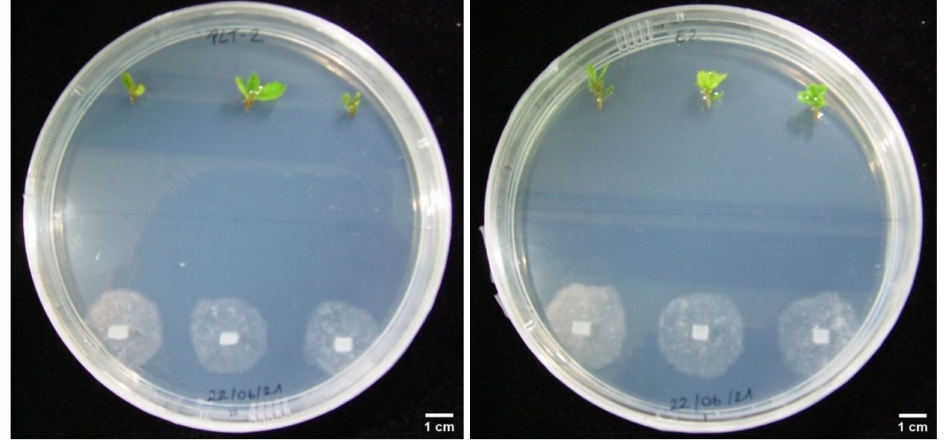
Figure 3. Growth of P. cinnamomi mycelia after 3 days of dual culture, when confronted with shoots of a Q. ilex tolerant (PL-T2, left ) and a control (E2, right )